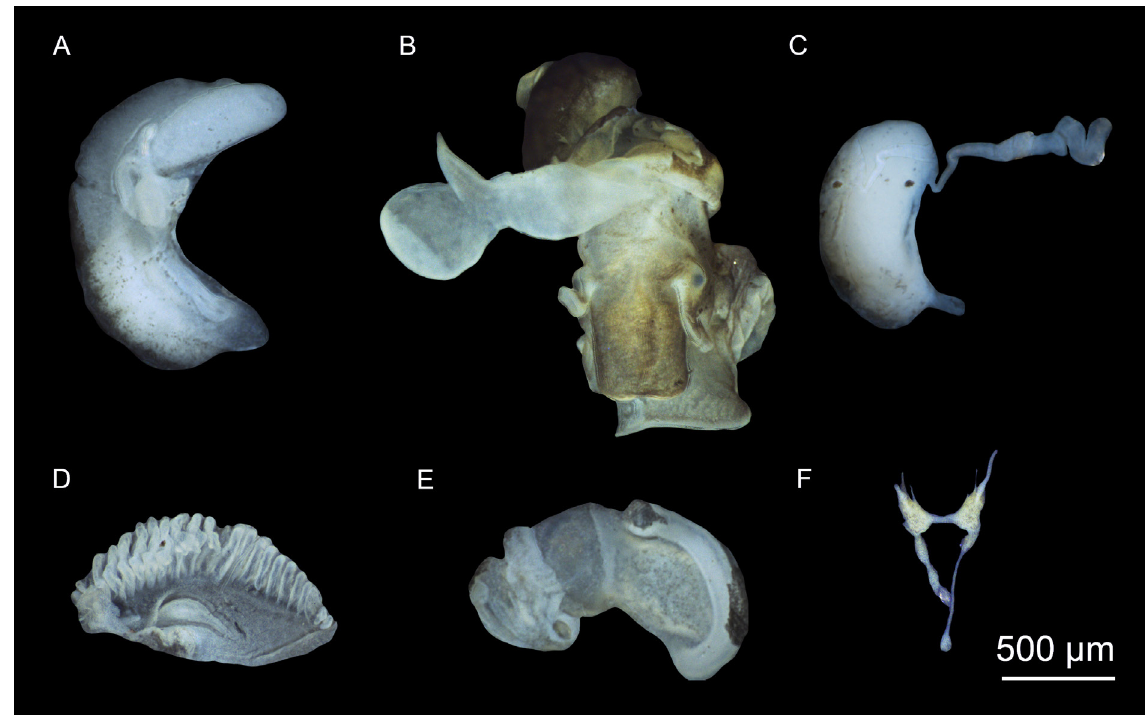
Fig. 10. Anatomy of Mercuria tachoensis (Frauenfeld, 1865) from Nascente do Senhor Jordão Spring, Alpedriz, Leiria, Portugal. A . Female genitalia. B . Animal and penis. C . Prostate gland. D . Ctenidium and osphradium. E . Stomach. F . Perioesophageal